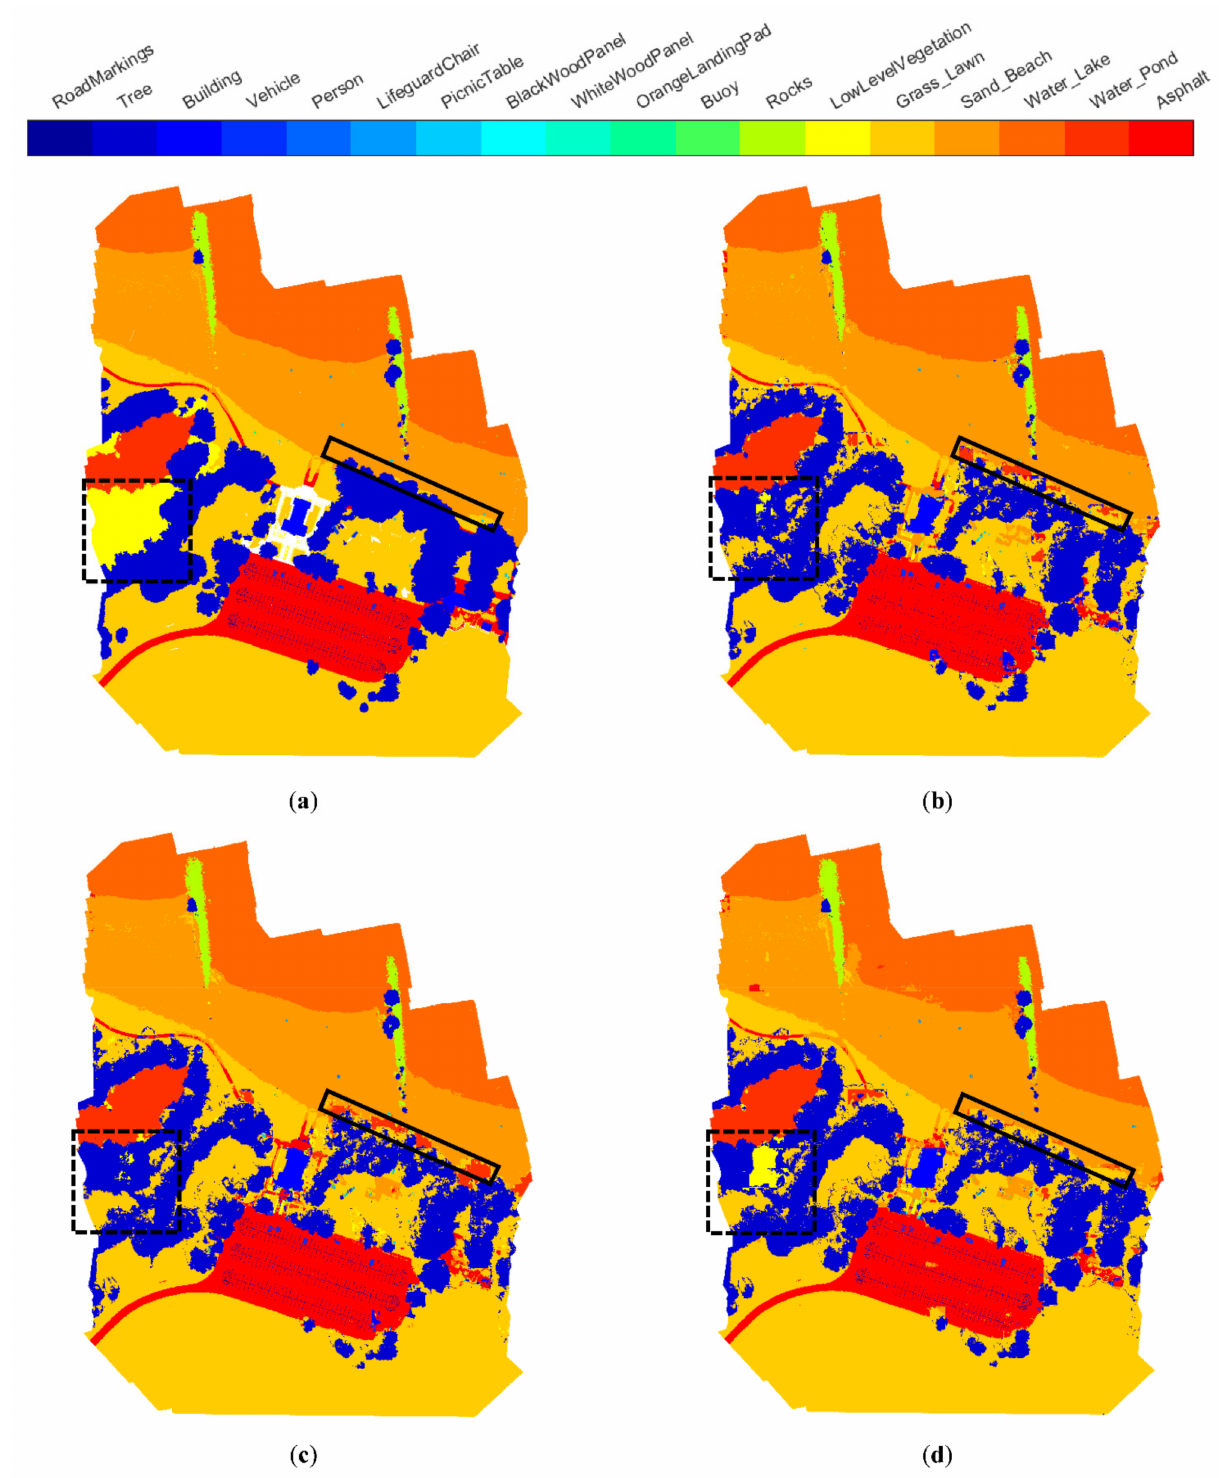
Figure 6. RIT-18 segmentation results of the test image: ( a ) ground truth, ( b ) segmentation map from ResNet50+ LC-Net, ( c ) segmentation map from HRNet-w18+ LC-Net, ( d ) segmentation map from Swin-tiny+